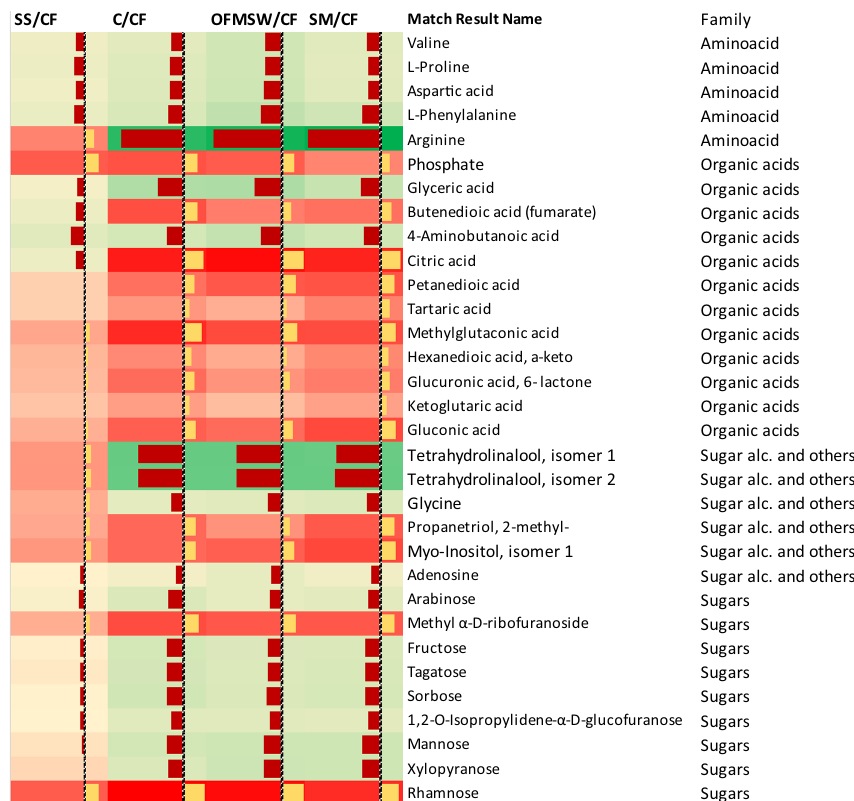
Figure 2. Heat map showing the log fold change ratio of the metabolites in lettuces between the different tested treatments and the chemical fertilization (CF) used as control. Only metabolites in which the comparison between treatment and control is statistically significant for at least one treatment are shown ( p value < 0.05). Plot was created with Microsoft Excel (version16.6.6, https:// www. micro soft.